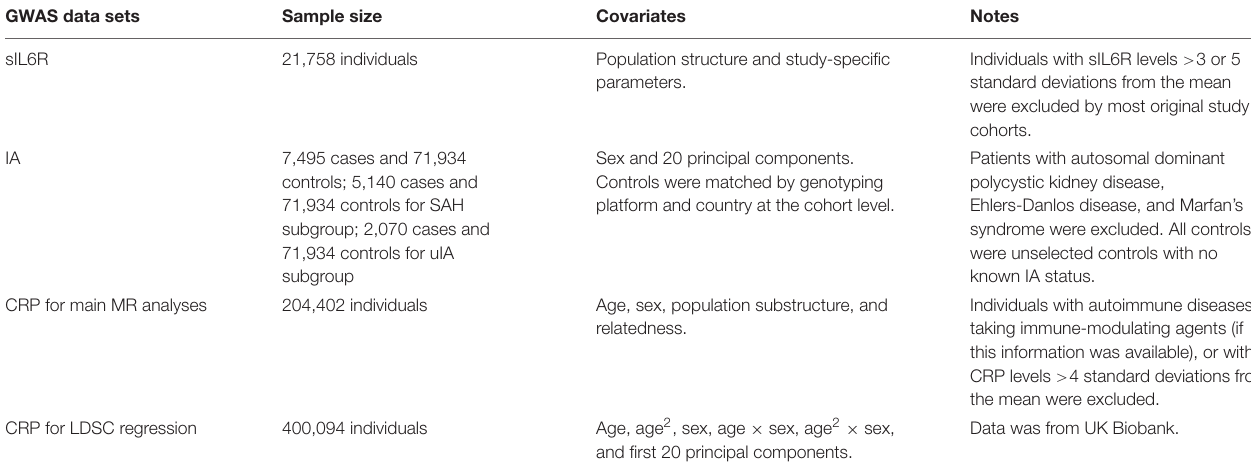
TABLE 1 | Characteristics of GWAS